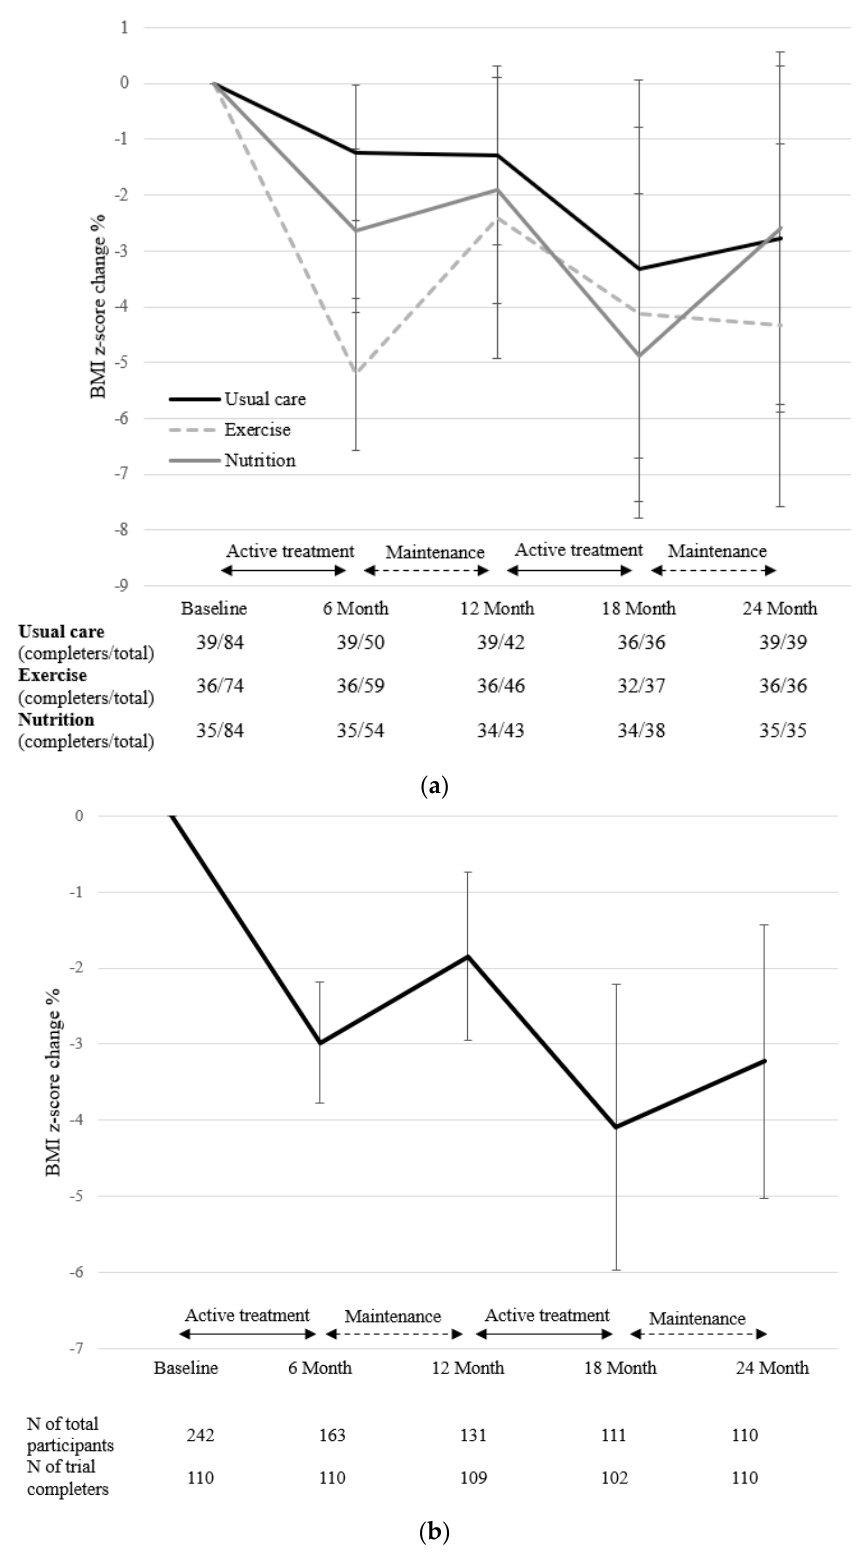
Figure 3. The course of BMI z-score change percentage from baseline according to the treatment stages. Linear mixed model adjusted for sex, age, attendance rate, calorie intake, and physical activity (METS). Figure shows means with standard error bars. ( a ) change % according to the intervention groups. Group effect ( p = 0.772), time effect ( p = 0.043), group × time interaction effect ( p = 0.976). ( b ) change % in total, adjusted for intervention groups: time effect ( p = 0.042).